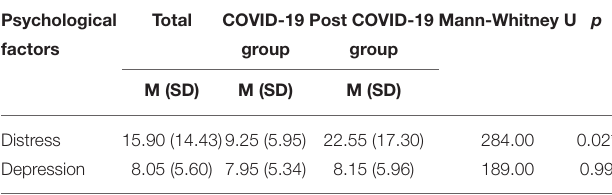
TABLE 4 | Comparison of emotional disturbances between COVID-19 and Post-COVID-19 groups.